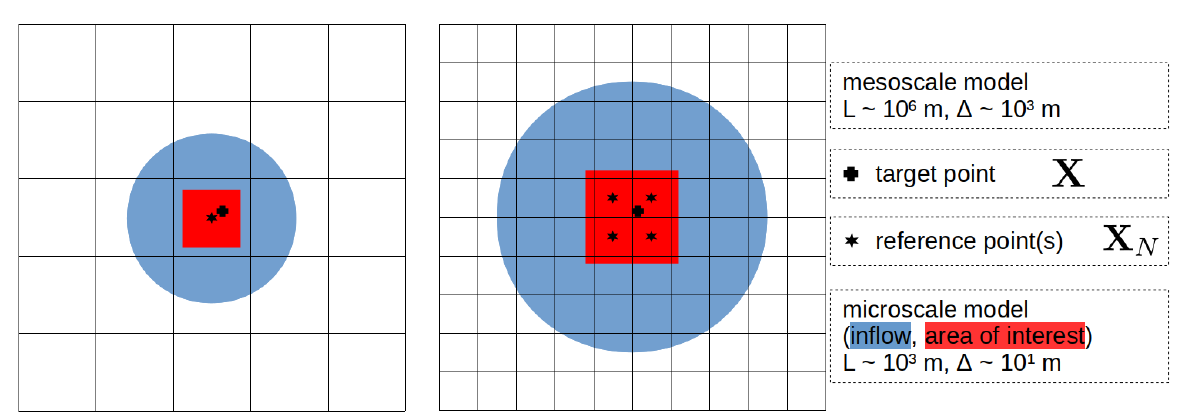
Figure 1. Two examples of setups of downscaling of meso-scale data with a micro-scale model: the size of the domain of the micro-scale model is given in blue (inflow domain with smoothed topography) and red (region of interest) colors, the grid below exemplary illustrates the grid of the meso-scale model. In the setup on the left-hand side, the small micro-scale model domain is within one grid cell of the meso-scale model and therefore only one reference point can be used. With larger computational power, the domain of the micro-scale simulation can be increased and the meso-scale model resolution can become finer (right). Therefore, to use several reference points becomes